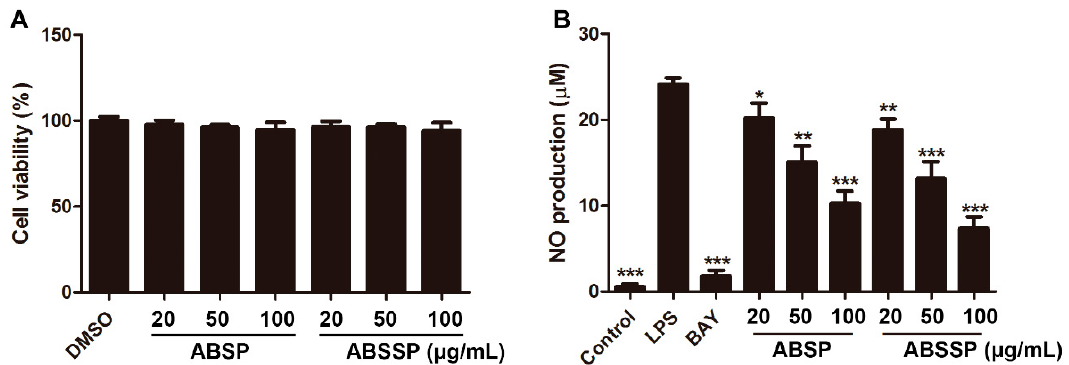
Figure 3. The effects of ABSP and ABSSP on cell viability and nitric oxide (NO) production in lipopolysaccharide (LPS)-stimulated RAW264.7 cells. ( A ) RAW264.7 cells were treated with different concentrations of ABSP or ABSSP for 24 h in the presence of LPS (0.5 μ g/mL). Cell viability was assessed using the Cell-Counting Kit-8 (CCK8) method and expressed relative to the vehicle control. ( B ) RAW264.7 cells were pretreated with the indicated concentrations of ABSP or ABSSP and BAY11-7082 (BAY, 5 μ M) for 2 h, and then exposed to LPS for an additional 24 h. Levels of NO in the culture medium were detected using Griess reagent. Data are expressed as mean ± SD, n = 3. * p < 0.05, ** p < 0.01, *** p < 0.001, compared with LPS.